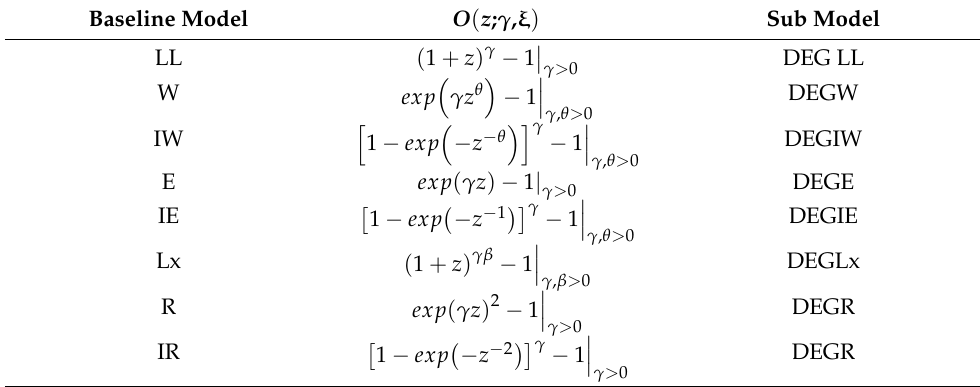
Table 1. Some new